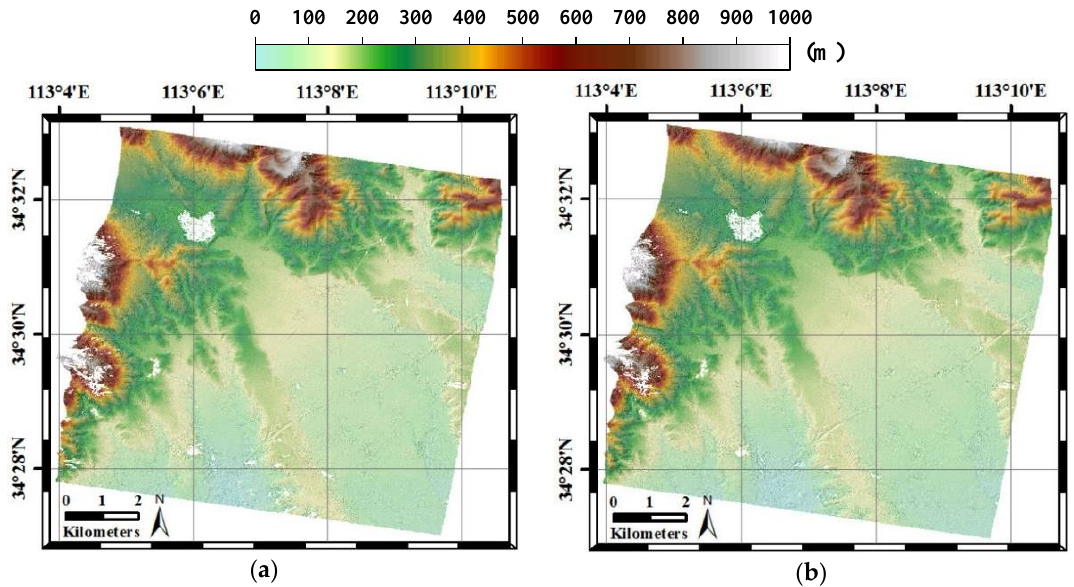
Figure 12. The digital elevation models acquired with ground control points (GCPs) ( a ) and without GCPs ( b ).